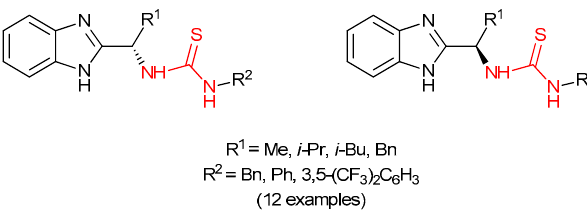
Figure 45. Novel chiral thioureas bearing benzimidazole fragment studied by Madabhushi et al [388].